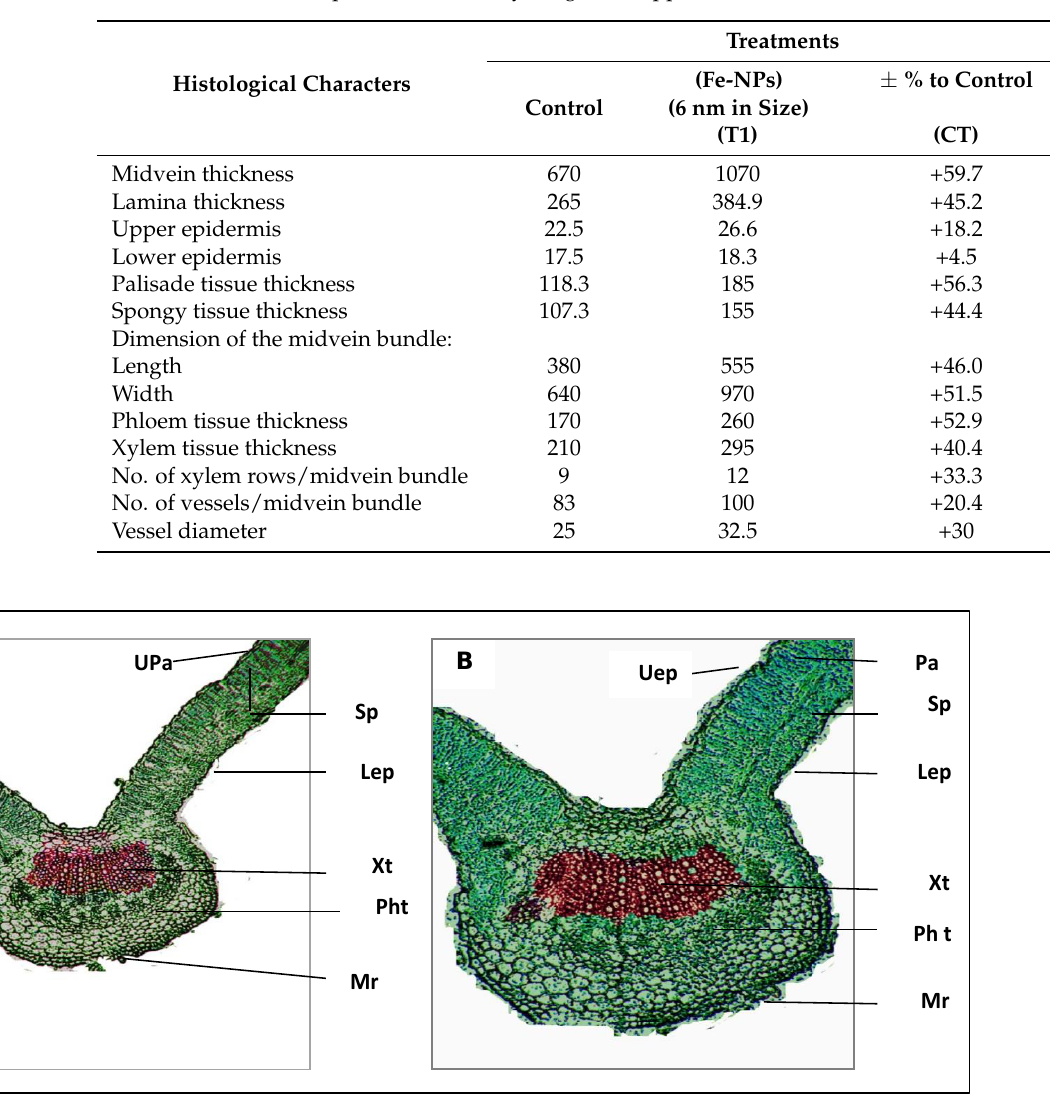
Table 6. Counts and measurements in microns ( µ ) of certain histological characters in transverse sections through the first leaflet blade of the compound leaf developed on the median portion of the main stem of faba bean plant as affected by exogenous application with FeNPs (T1).